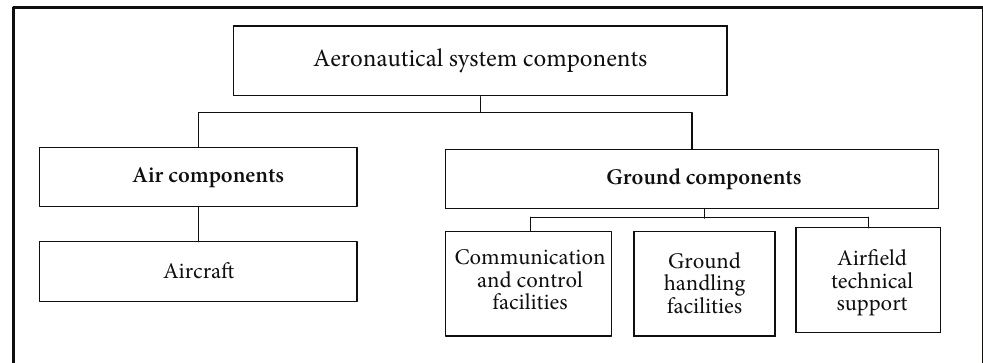
Fig. 1. Aeronautical system